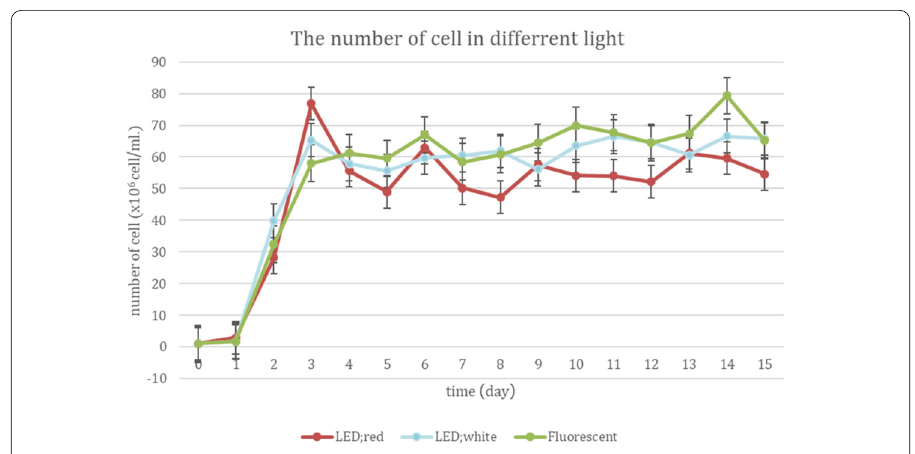
Figure 2 The graph between the density of C.vulgaris cell and time using different light sources, 4000 lux, 12hr:12hr light/dark cycle, 0.4 vvm air flow rate, with temperature 28 ± 2 ◦